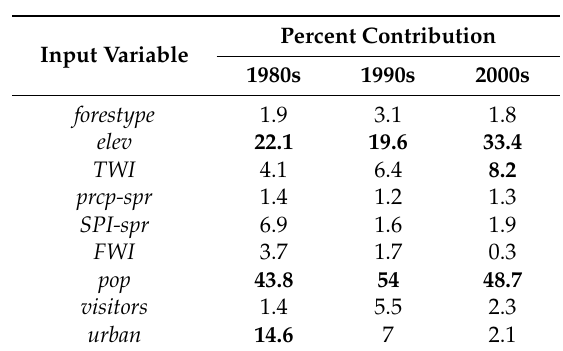
Note. Bold indicates